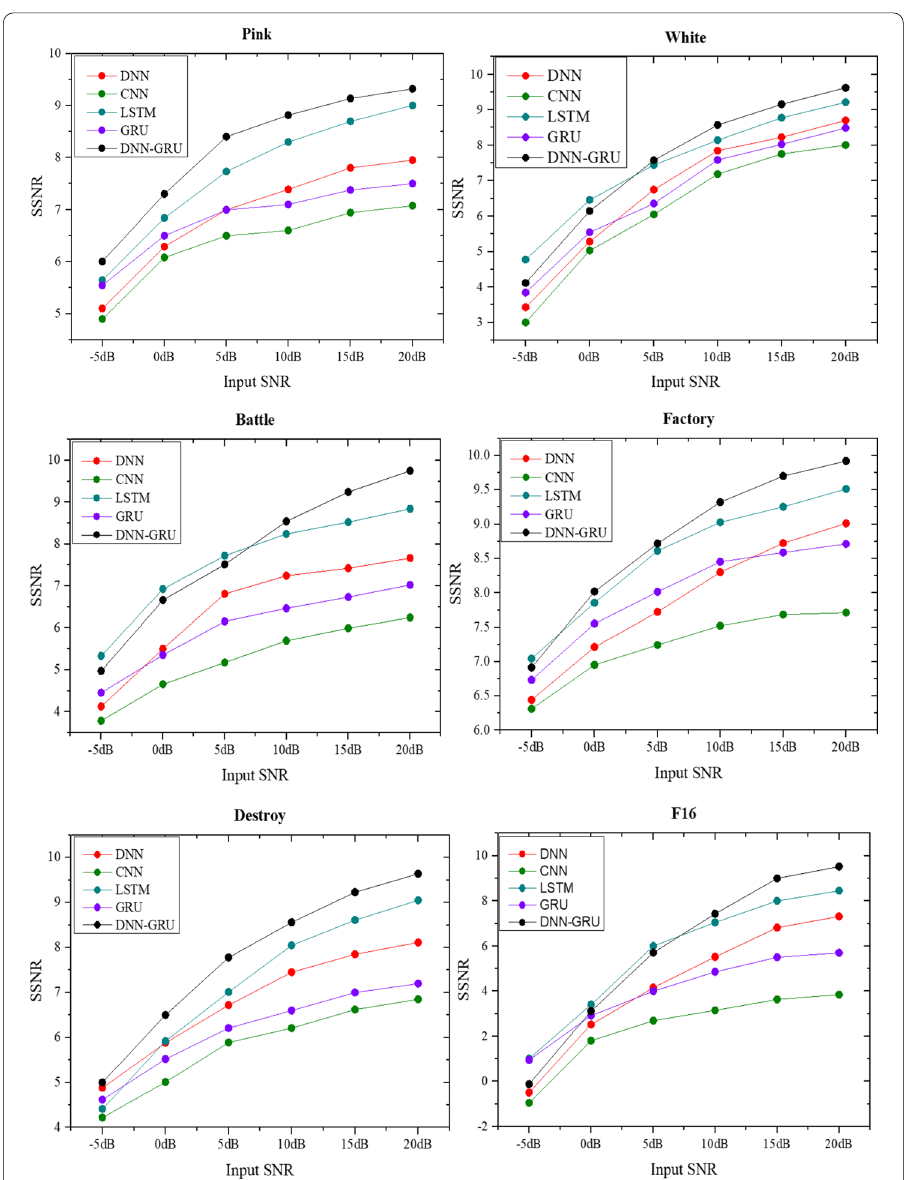
Fig. 7 The SSNR results at different